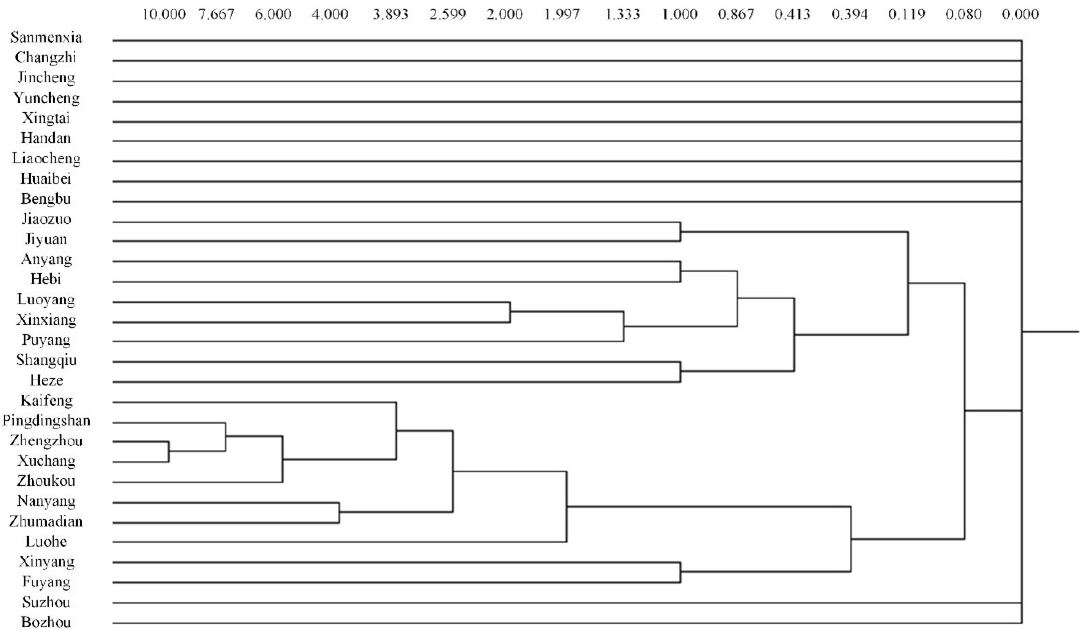
Figure 8. Single-link clustering based on cohesive subgroups.